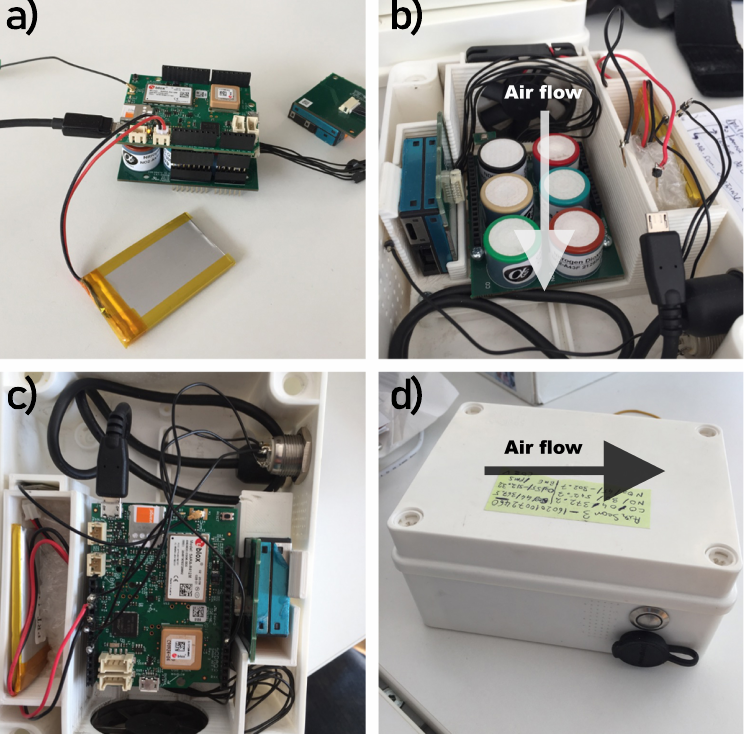
Figure 1. Airify air monitoring device: ( a ) the device without the case is made of two stacked boards: one for the sensors and another one used for processing purposes. The particle sensor is attached to the stack via a cable to reduce possible interference with its own fan. In case of a power shortage, the battery allows 4 h of autonomy. ( b ) The sensor board is placed at the bottom. A fan placed on the upper wall ensures that the air flows towards the sensors. The particle sensor has its own fan and the in/out openings are separated by the case to reduce the chance for a tunnel between them. ( c ) The processing board is placed on top. The two boards create a tunnel for air to flow over the sensors. ( d ) The Airify inside a case. The case has openings lengthways to create the air tunnel and also on the side for the particle sensor. On the side, the case has the power/indicator button and the charging